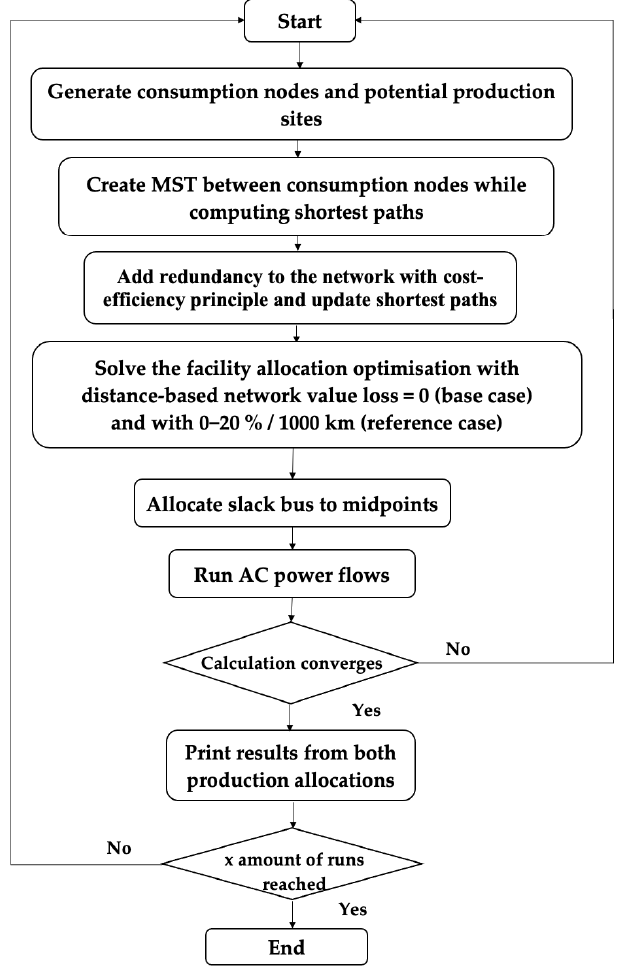
Figure 1. Flowchart of the presented algorithm investigating the impacts of distance-based value losses.